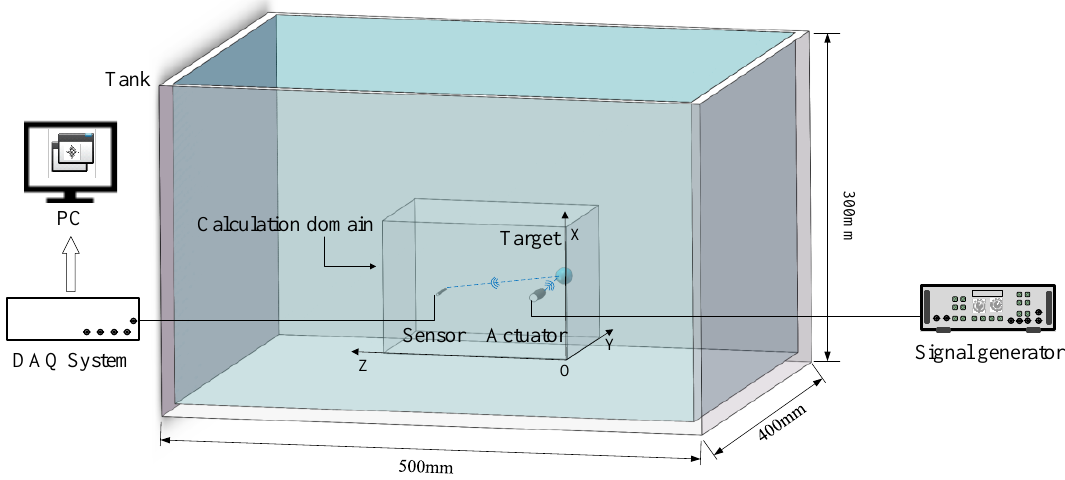
Figure 1. Experimental setup illustration. The target, actuator, and sensor are immersed in water.